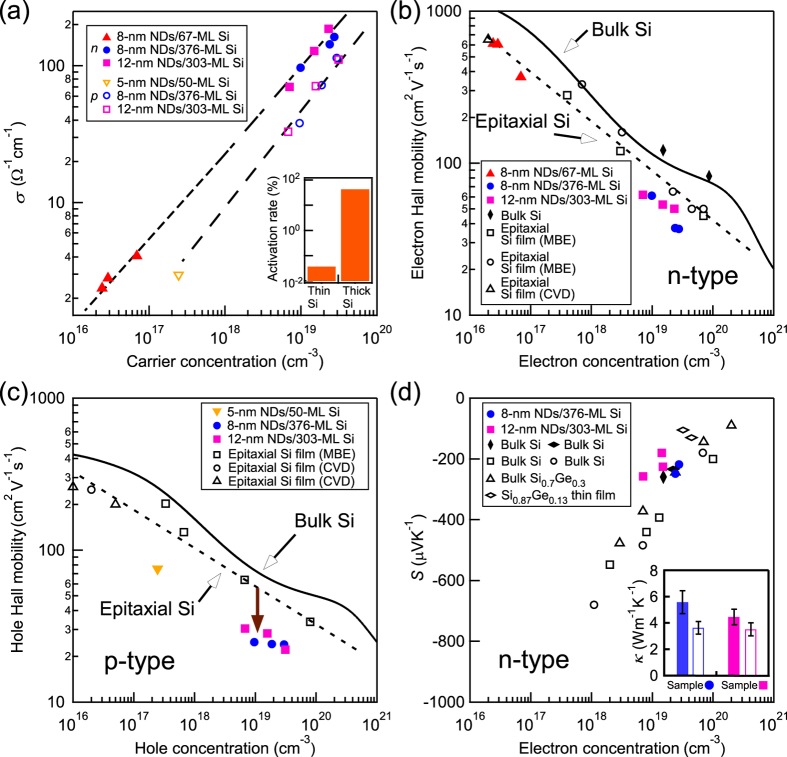
(a) Electrical conductivities of our nanoarchitectures. The solid and open marks indicate P- and B-doped nanoarchitectures, which exhibited n-type and p-type conductivities, respectively. The dashed lines are denoted for eye-guide. The inset shows the carrier activation rate of nanoarchitectures in the case of thin (~70 ML) and thick (>300 ML) Si layers. (b) Hall mobilities of P-doped (n-type) and (c) B-doped (p-type) nanoarchitectures, respectively. The solid marks denote our studies. The open marks indicate the values of reported epitaxial Si films on Si substrate with the dashed lines for eye-guide. In (b), open square, circle and triangle marks indicate the reported values of MBE3940 and CVD41, respectively. In (c), the open square, circle and triangle marks indicate the reported values of MBE40 and CVD4243, respectively. The solid lines are those of bulk Si calculated by empirical formula44. (d) Seebeck coefficients of P-doped typical stacked structure (8-nm NDs/376-ML Si sample and 12-nm NDs/303-ML Si sample). Open square, circle, triangle and diamond marks indicate the reported values of bulk Si 945, Si0.7Ge0.3 45 and Si0.87Ge0.13 thin film46 for reference. The inset shows the thermal conductivities of non-doped (solid bar) and doped (open bar) nanoarchitectures. Dose condition is summarized in Table SI and SII in Supplementary Information. In the same samples, the larger dose causes the larger carrier concentration.